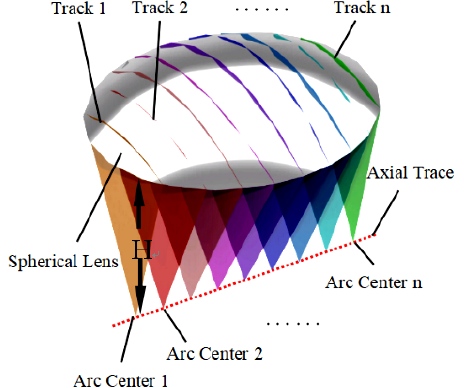
Figure 3. Trajectory characteristics of stylus at different off-axis degrees.